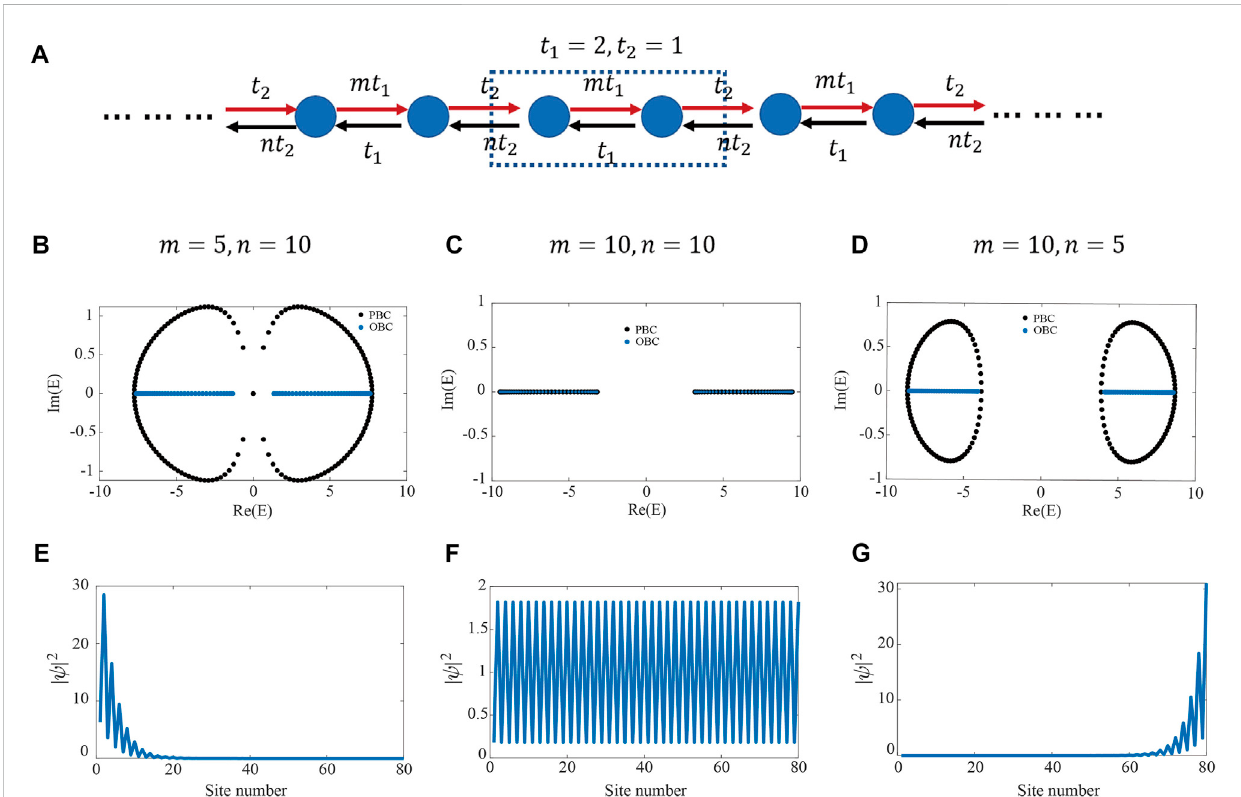
FIGURE 1 (A) Schematics of a 1D non-Hermitian SSH-like model with non-reciprocal hoppings between NN sites. Dashed rectangle encloses the unit cell. Blue dots denote sublattice sites. Leftward hoppings of intracell and intercell are represented by symbols t 1 and nt 2 while mt 1 and t 2 for rightward hoppings.Thescalingfactorsofhoppingstermswithinandacrossunitcellsareseparatelydenotedas m and n .ThecomplexspectraunderPBCandOBC and superimposed intensity pro fi les under an open chain are calculated and exhibited in (B) (E) for the case of m (cid:1) 5 , n (cid:1) 10, in (C) (F) for m (cid:1) 10 , n (cid:1) 10 , and in (D) (G) for m (cid:1) 10 , n (cid:1)